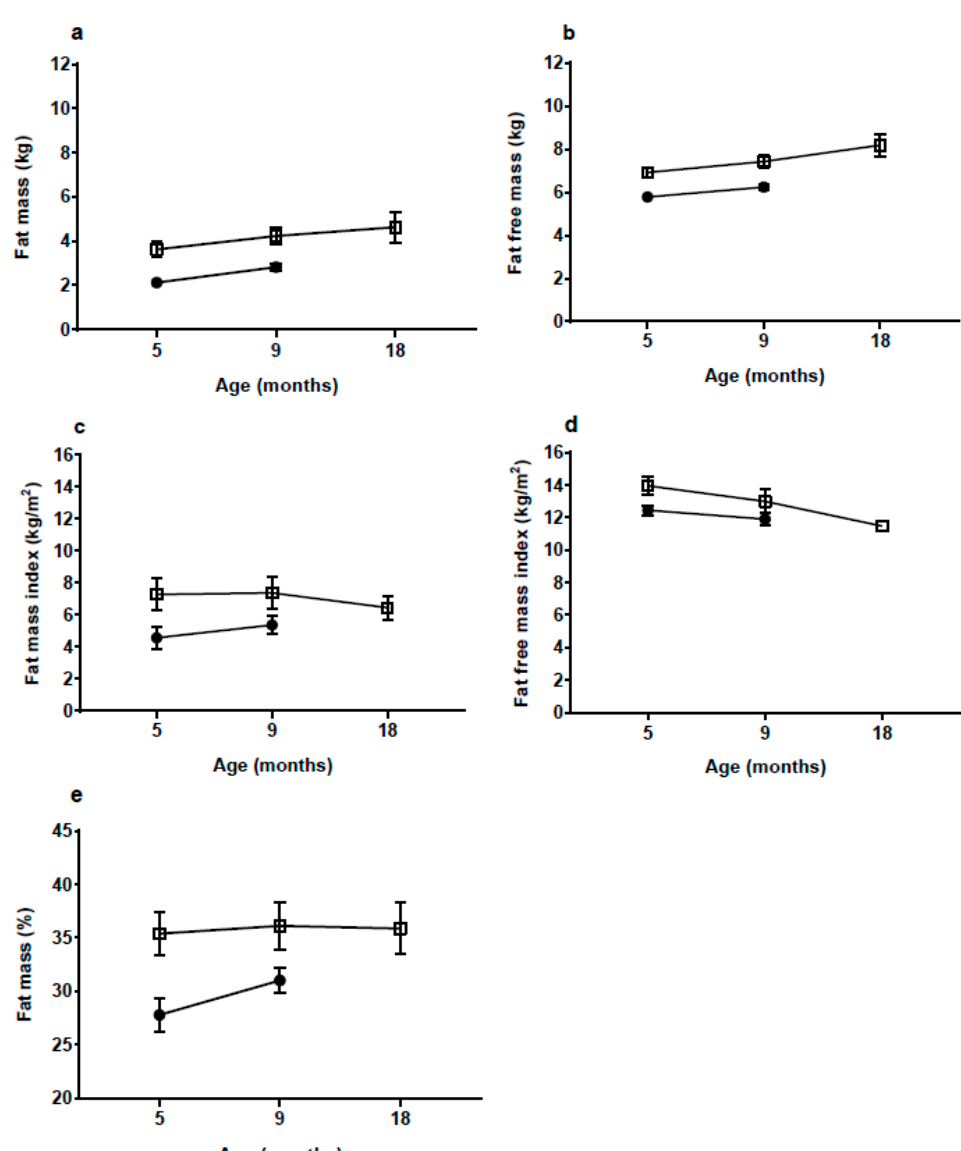
Figure 3. ( a ) fat mass; ( b ) fat free mass; ( c ) fat mass index; ( d ) fat free mass index and ( e ) fat mass